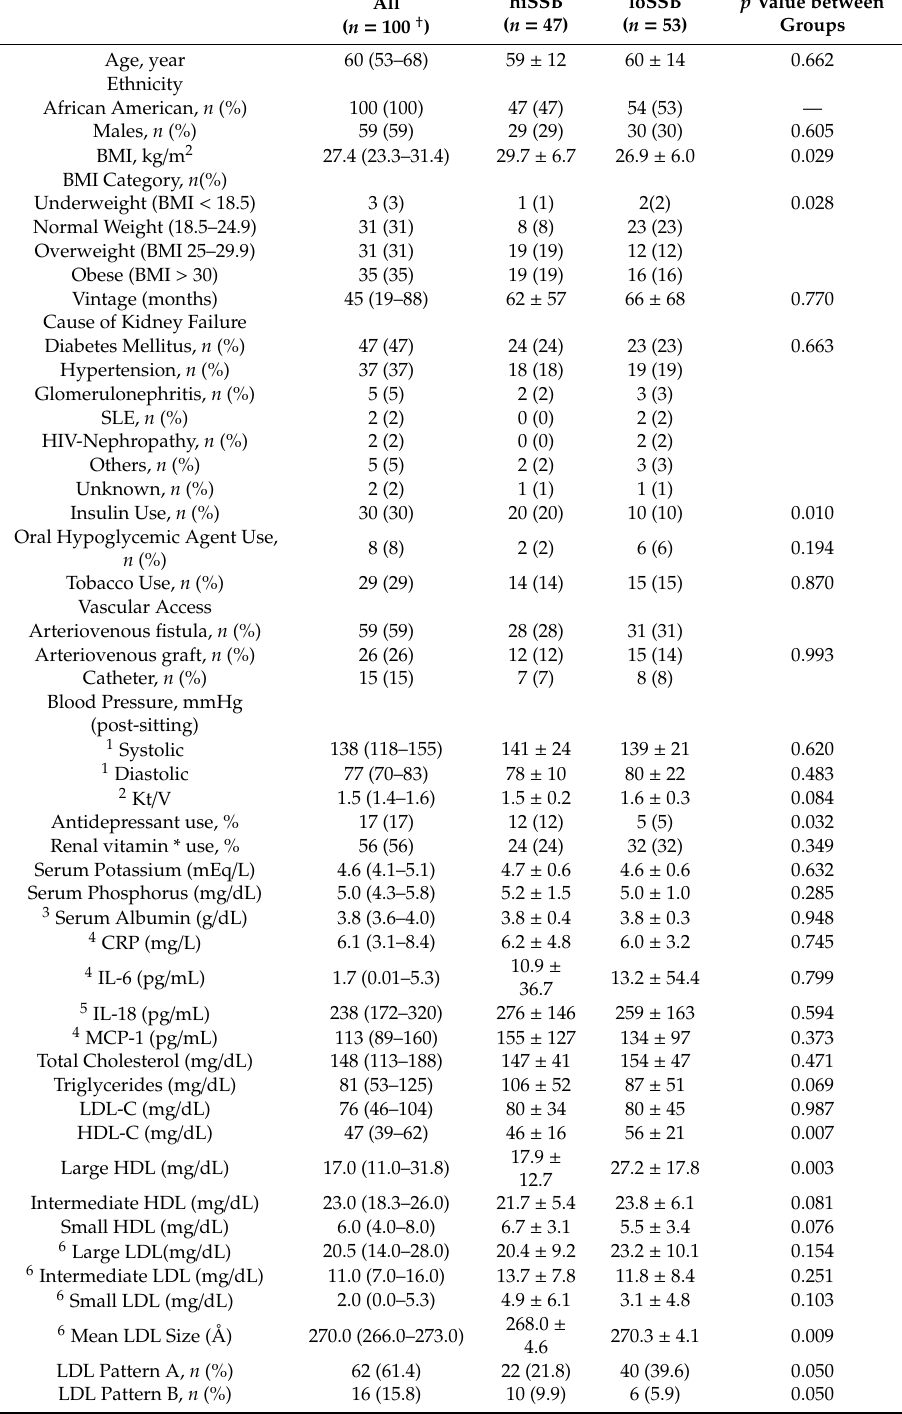
Table 2. Patient characteristics at baseline according to diet